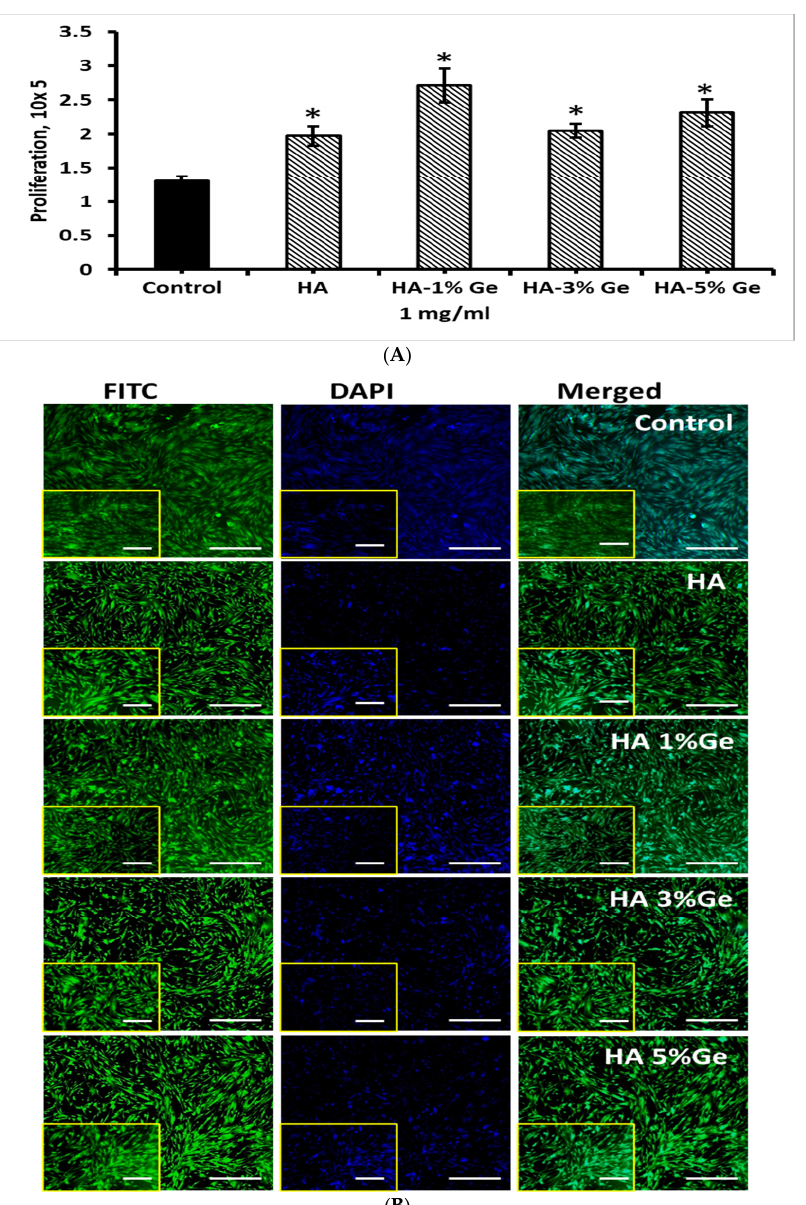
Figure 11. ( A ) Cell count and ( B ) Fluorescence (FITC, DAPI and merged) images of BM-MSCs cultured with HA-Ge coating. Control—BM-MSCs cultured without HA or HA-Ge composites, HA—HA without Ge, HA-1%Ge—HA with 1% germanium, HA-3%Ge—HA with 3% germanium, and HA-5%Ge—HA with 5% germanium. Scale bar 5×-200 µm, 10×-100 µm (Insert). * denotes statistical significance, p <0.05 vs. control